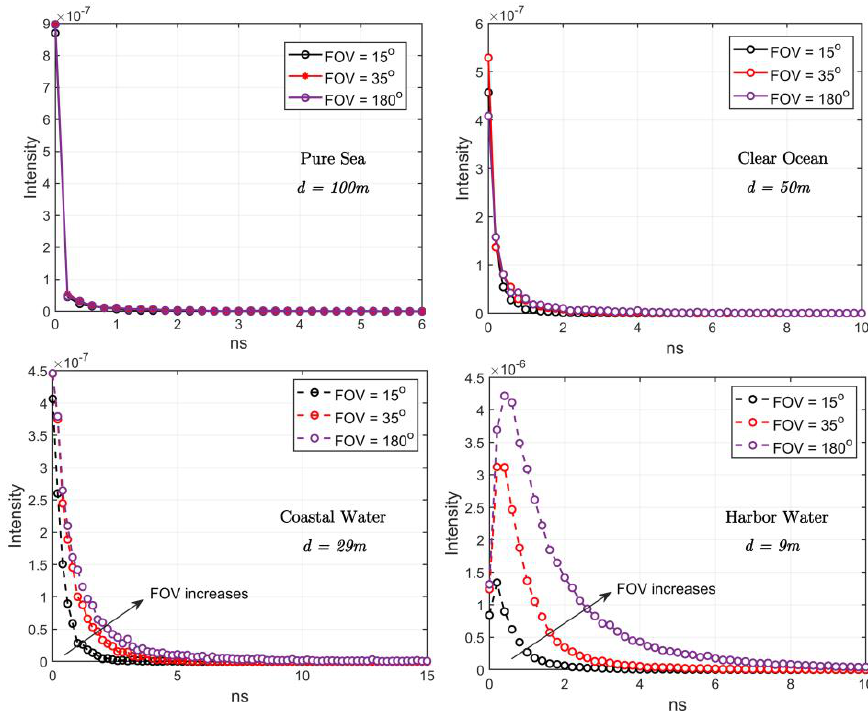
Figure 5. Illustration of the CIR curve for different water types under various system configurations.